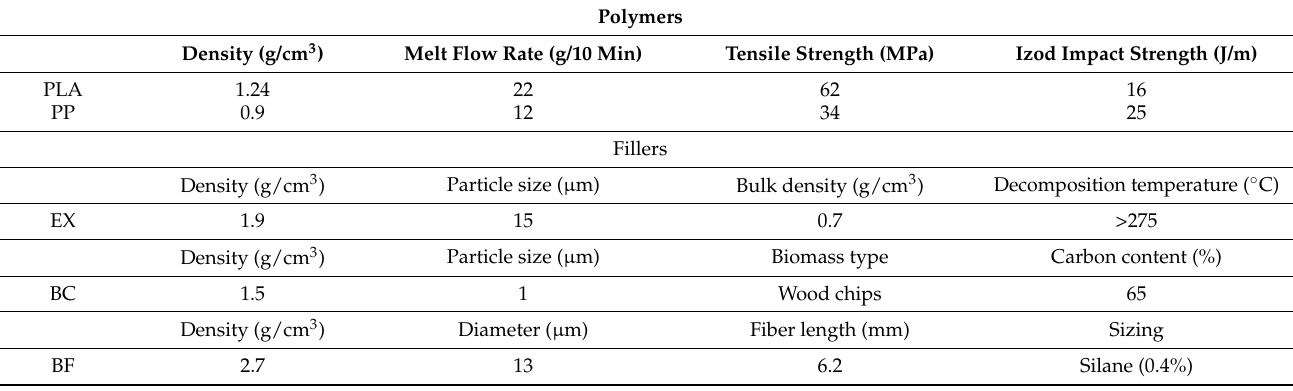
Table 1. The list of basic properties of the pure polymers and